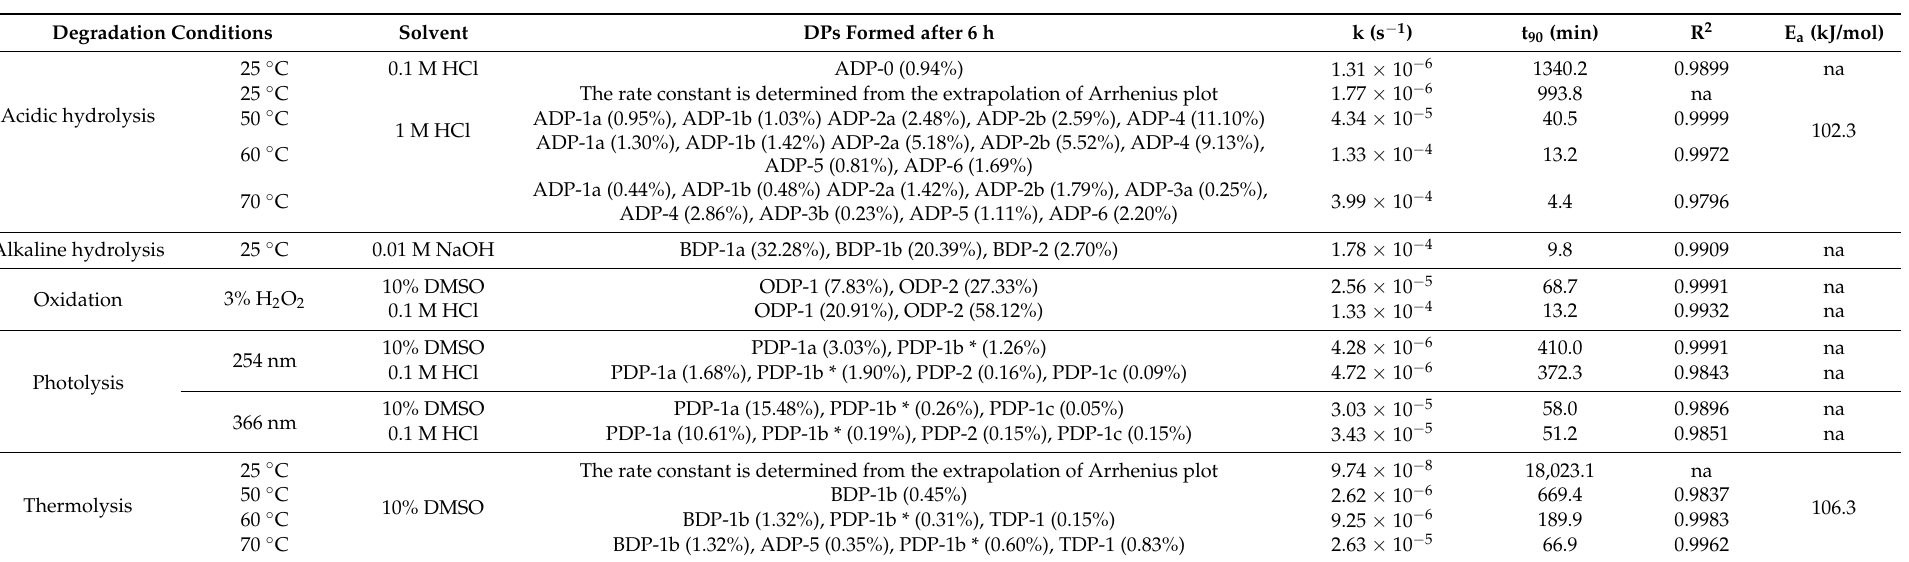
Table 3. Experimental stress conditions in solution-state studies (solvents, temperatures and/or irradiation wavelengths), the percentage of DPs formed after 6 h of degradation, and the calculated degradation rate constants with R 2